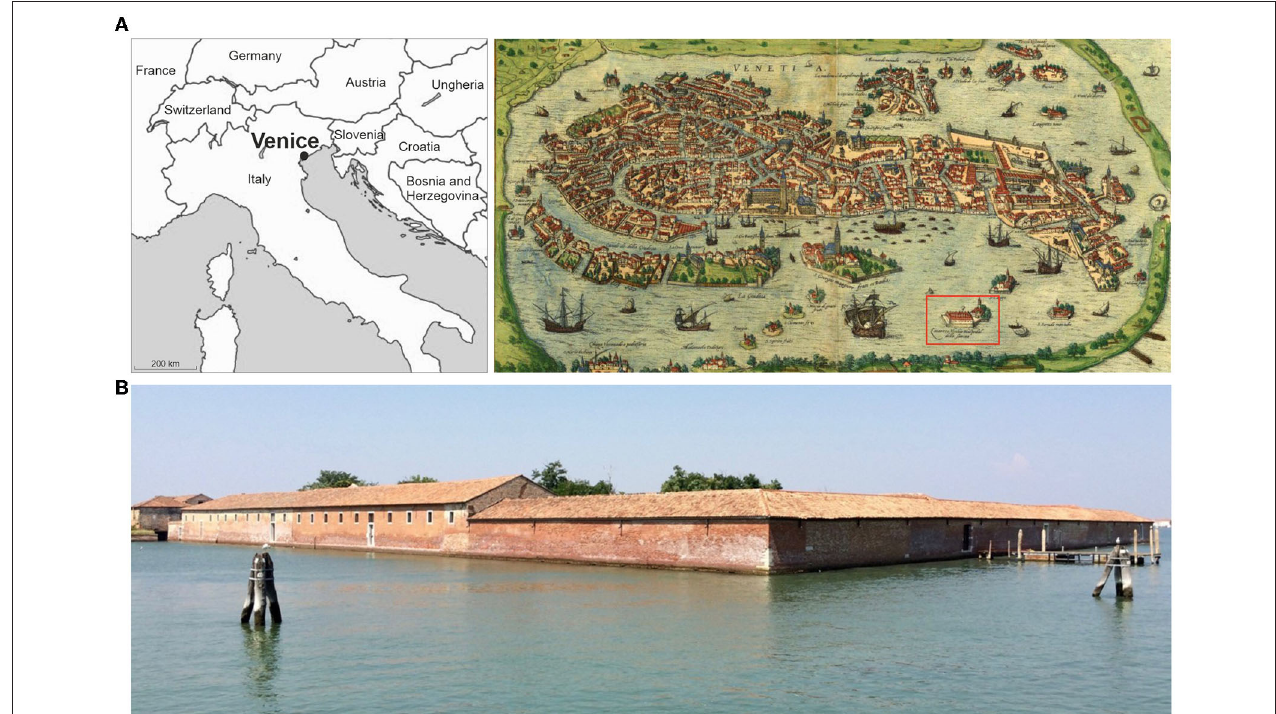
FIGURE 1 | Venice, Italy: The Lazaretto Vecchio. (A) A sixteenth century map of Venice with the location of the Lazzaretto Vecchio (11) and (B) A recent image of the Lazzaretto Vecchio (photographed by H. Moots). The Lazzaretto Vecchio was established in 1423 about 2km from Venice on a small island, close to modern Lido. It occupied a strategic location at the entrance to the Venetian lagoon from the Adriatic Sea. It was established some distance from the main inhabited islands, but still relatively closed to landing points so that goods could be easily transported, and passengers disembarked once quarantine was over.